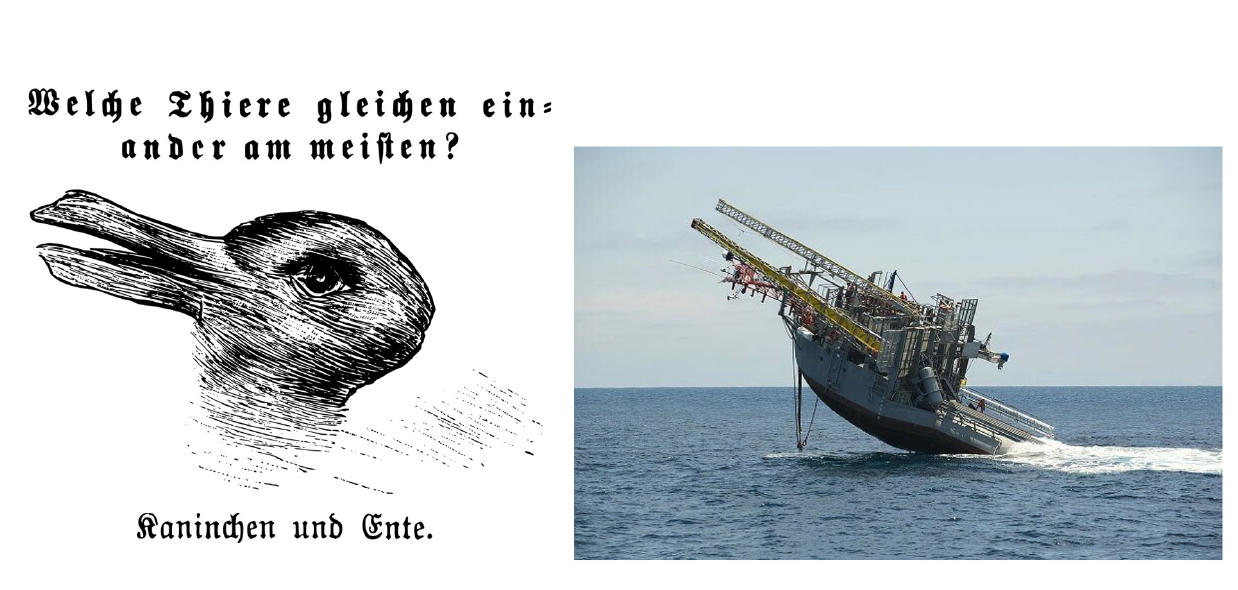
Figure 4a: “Kaninchen und Ente” (“Rabbit and Duck”), from the October 23, 1892, issue of Fliegende Blätter .* Ludwig Wittgenstein adapted this image into his famous duck-rabbit cartoon in Philosophical Investigations (1953, 194). Figure 4b: FLIP in midflip. Photo: John F. Williams, US Navy/CC. Public domain. *Digitized at